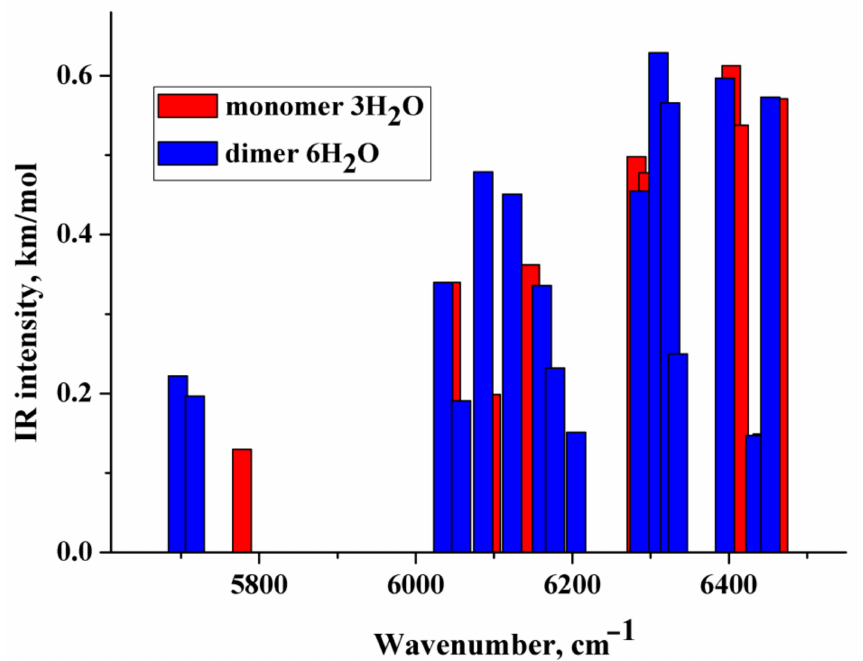
Figure 7. Theoretical IR spectra of the diclofenac anion hydrated with three water molecules (red columns) and dimer of the diclofenac anion hydrated with six water molecules (blue columns). Vibrations having relative IR intensities less than 0.20 are not